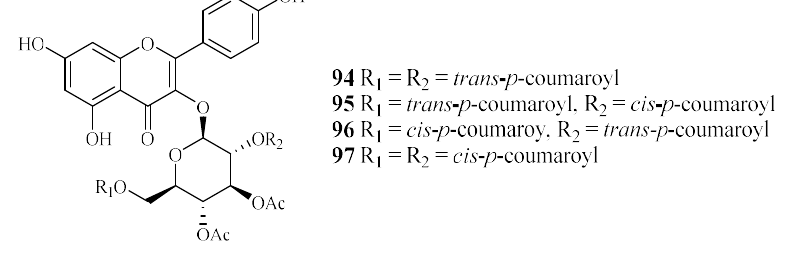
Figure 18. Compounds from a Fagaceae plant.